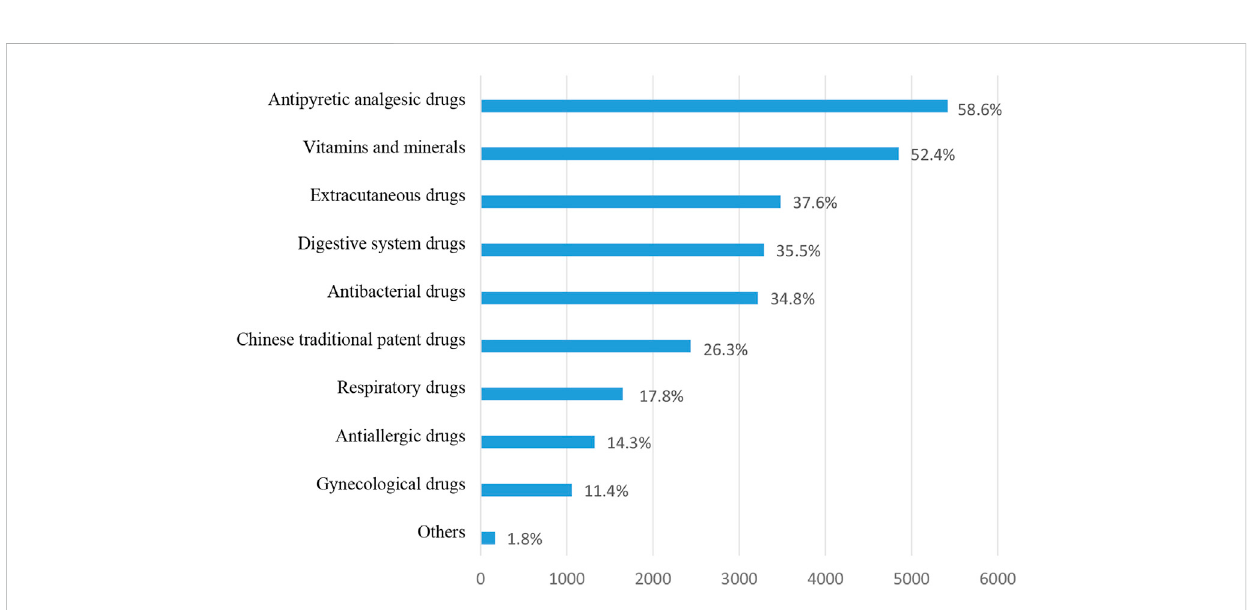
FIGURE 2 Types of OTC drugs purchased by